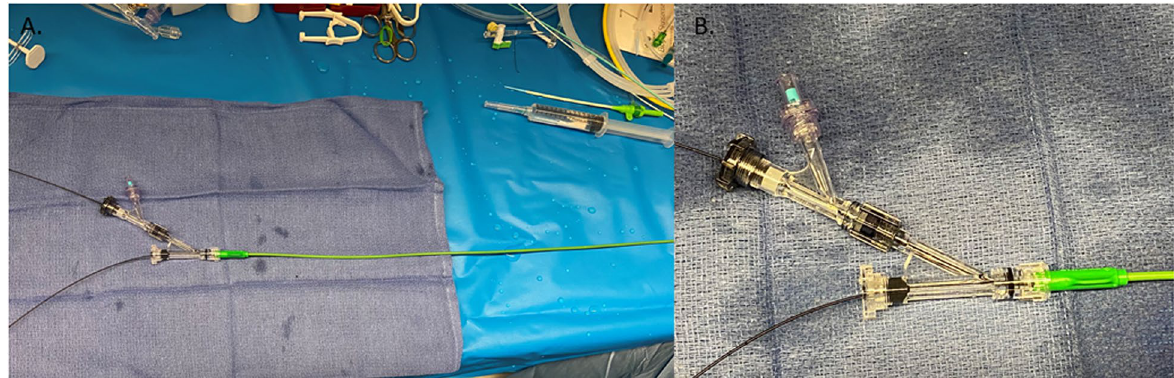
Fig. 2 a Set up for double balloon technique . The hemostatic valve of a Destination sheath is removed and replaced with a rotating hemostatic valve. The microcatheter is introduced into the vascular sheath and a rotating hemostatic valve is used. b Through the flush port of the rotating